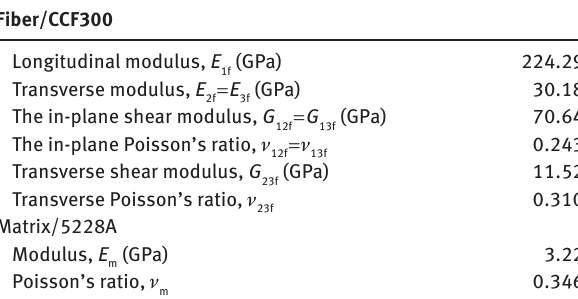
Table 1: The material properties of CCF300/5228A